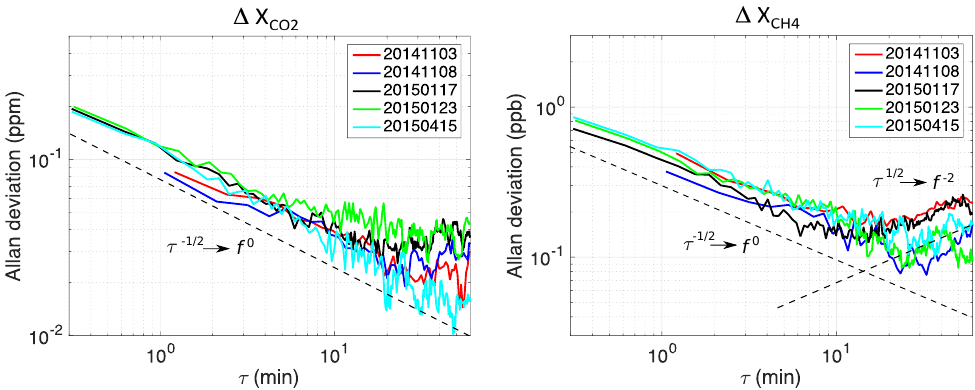
Figure 1. Allan deviations σ allan ,(cid:49)X as a function of the integrating time τ . The black dashed lines represent a slope and σ allan ,(cid:49)X CH4 CO2 of − 1 / 2 and a slope of 1 / 2, which correspond to power spectral densities S(f ) = f 0 (white noise) and S(f ) = f − 2 (Brownian noise), respectively. The Allan deviation follows a slope of − 1 / 2 up to an integration time of 10 to 20min, then stays constant ( S(f ) = f − 1 ), and subsequently turns over to a slope of 1 / 2, which describes a